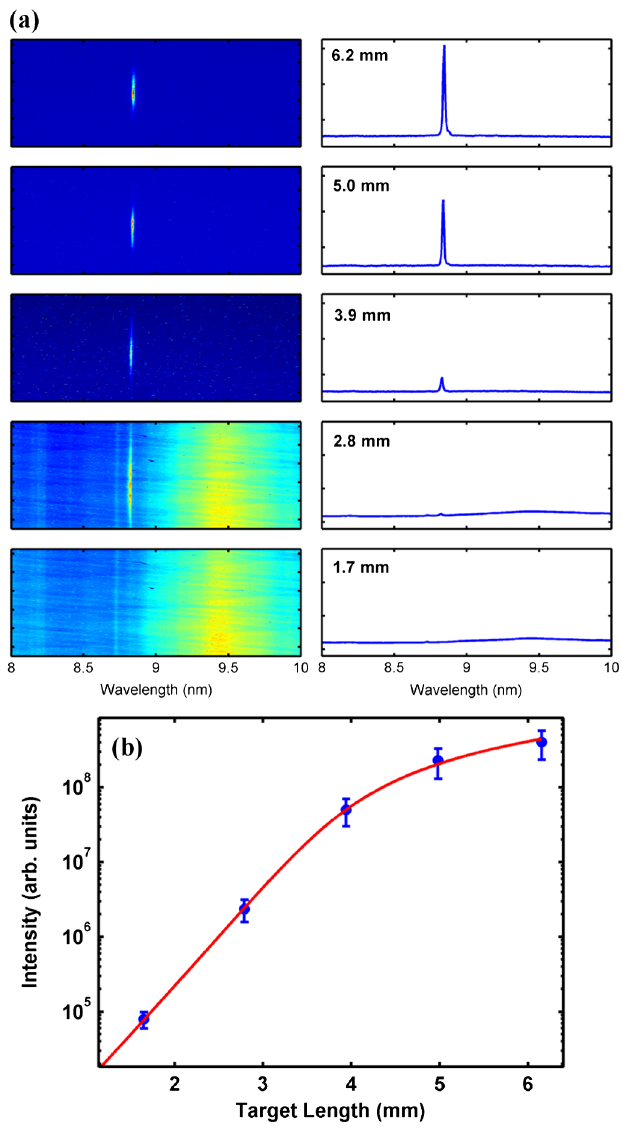
FIG. 2. (a) End-on spectra of a line-focus lanthanum plasma column showing saturated amplification in the (cid:1) ¼ 8 : 85 nm line of Ni-like La. (b) Intensity of the (cid:1) ¼ 8 : 85 nm laser line as a function of the plasma-column length. The line is a fit of the data that yields a gain coefficient of 33 cm (cid:2) 1 and a gain-length product of 14.6. The points are the average of 10 laser shots and the error bar represents 1 standard deviation.